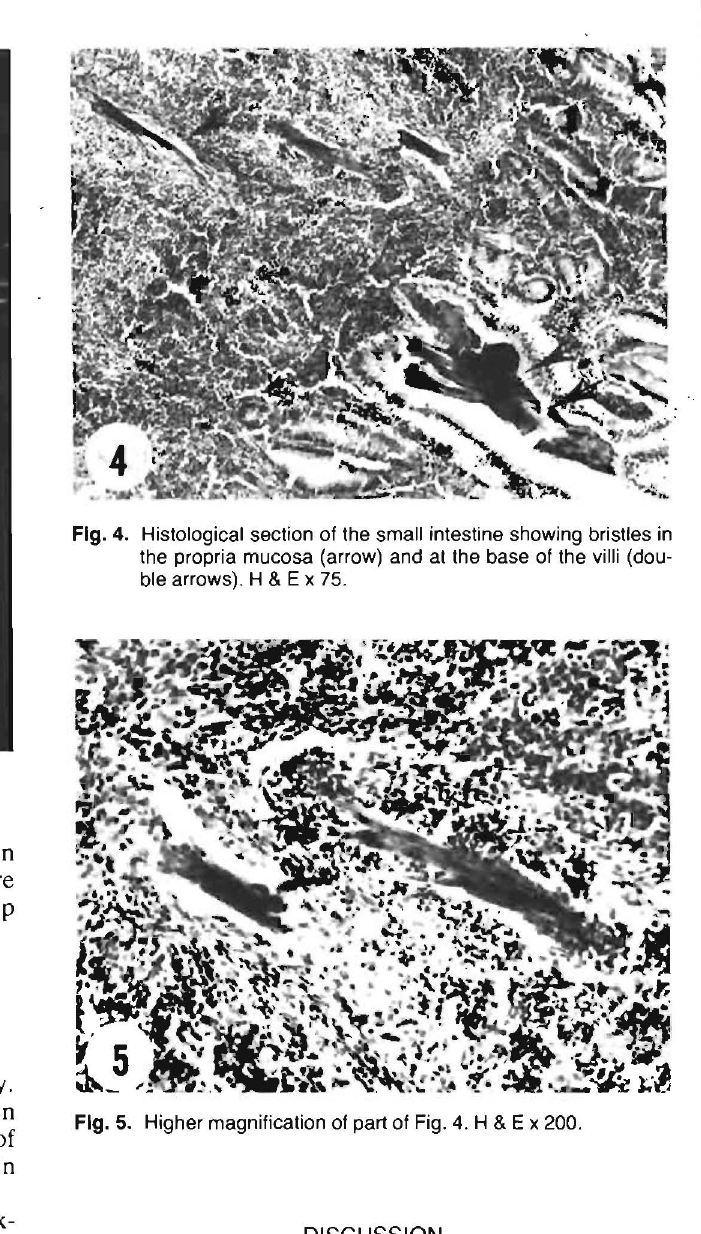
Fig. 5. Higher magnification of part of Fig. 4. H & E x